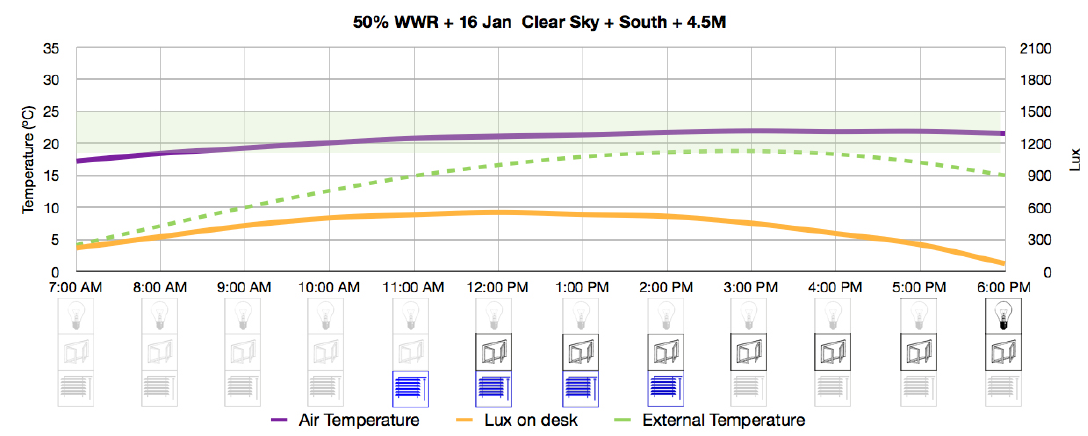
Figure 20. 50% WWR + Clear sky 4.5 m from the SOUTH